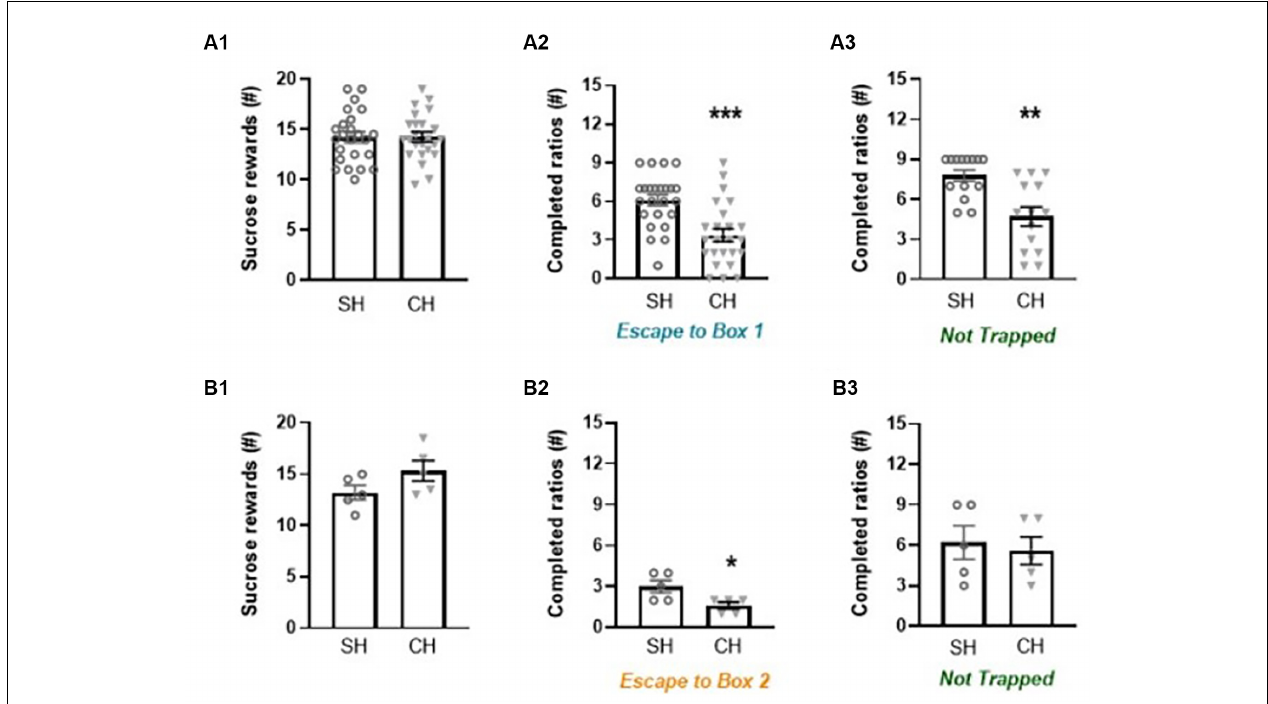
FIGURE 5 | Effect of complex housing on sucrose reward and behavior in the liberation task. The motivation to work for sugar (number of sucrose rewards earned) in a progressive ratio design is depicted in the (A1) and (B1) graphs. The motivation to liberate a cage mate (number of completed ratios) in an adapted progressive ratio design is depicted in the (A2) and (B2) graphs. Motivation to open the doors in the Not Trapped configuration is depicted in the (A3) and (B3) graphs. Panel (A) shows the main experiment with Sucrose reward (n = 24 in each exp group) , Escape to box 1 ( n = 24 in each exp group ) and not Trapped ( n = 14 in each exp group ) configurations, and Panel (B) shows preliminary data with Sucrose reward , Escape to box 2 a nd not Trapped configurations (n = 5 in each exp group) . Data represent individual data points and mean ± SEM. * p < 0.05, ** p < 0.01, ∗∗∗ p <